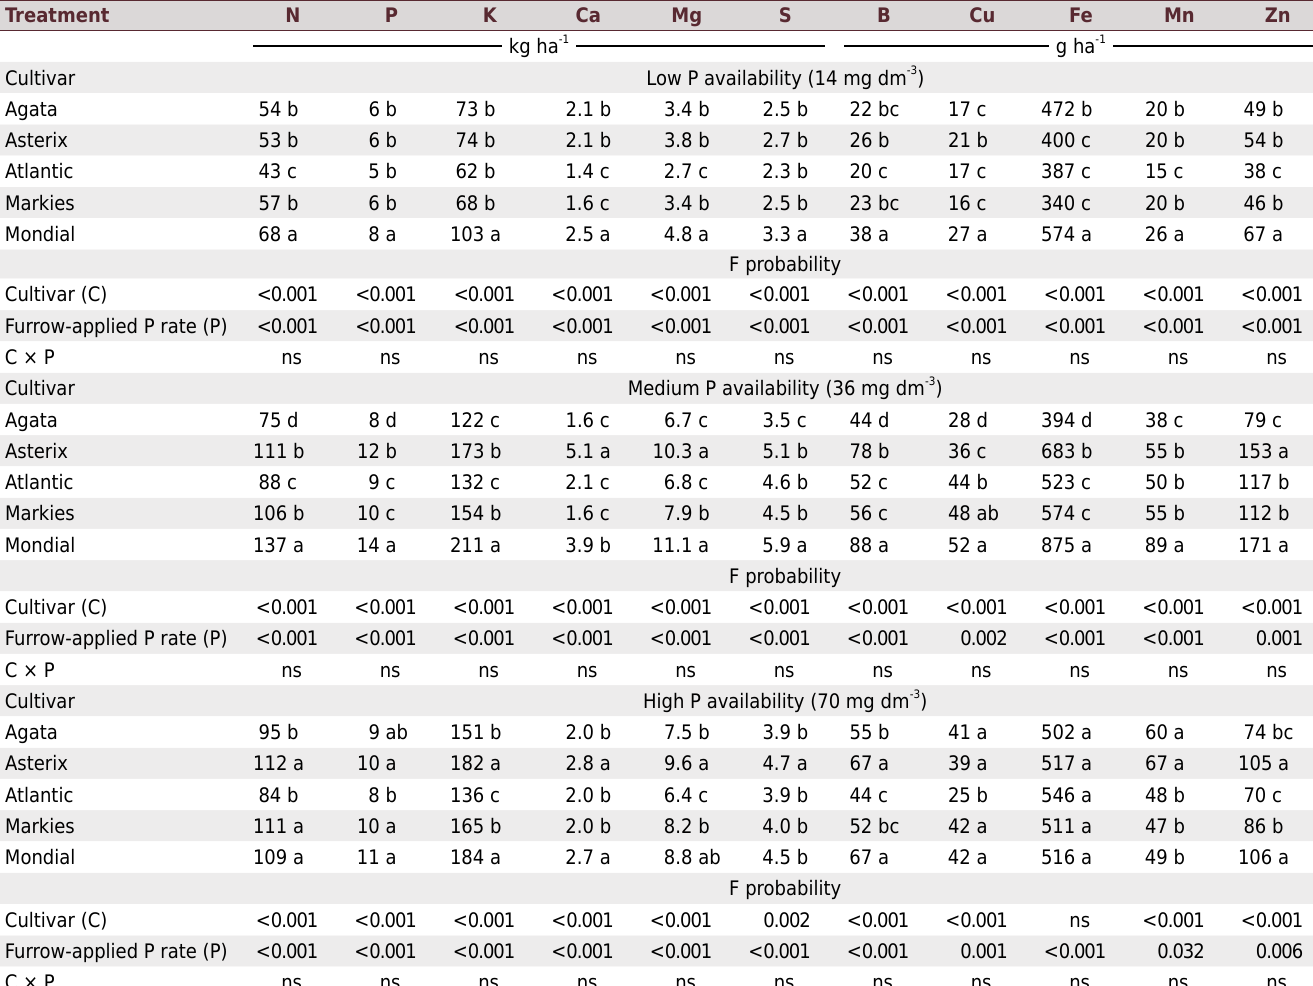
Table 5. Nutrient (N, P, K, Ca, Mg, S, B, Cu, Fe, Mn, and Zn) removal by tubers of the potato cultivars as affected by rates of P applied in the planting furrow in soils with low, medium, and high P availability Treatment N P K Ca Cultivar